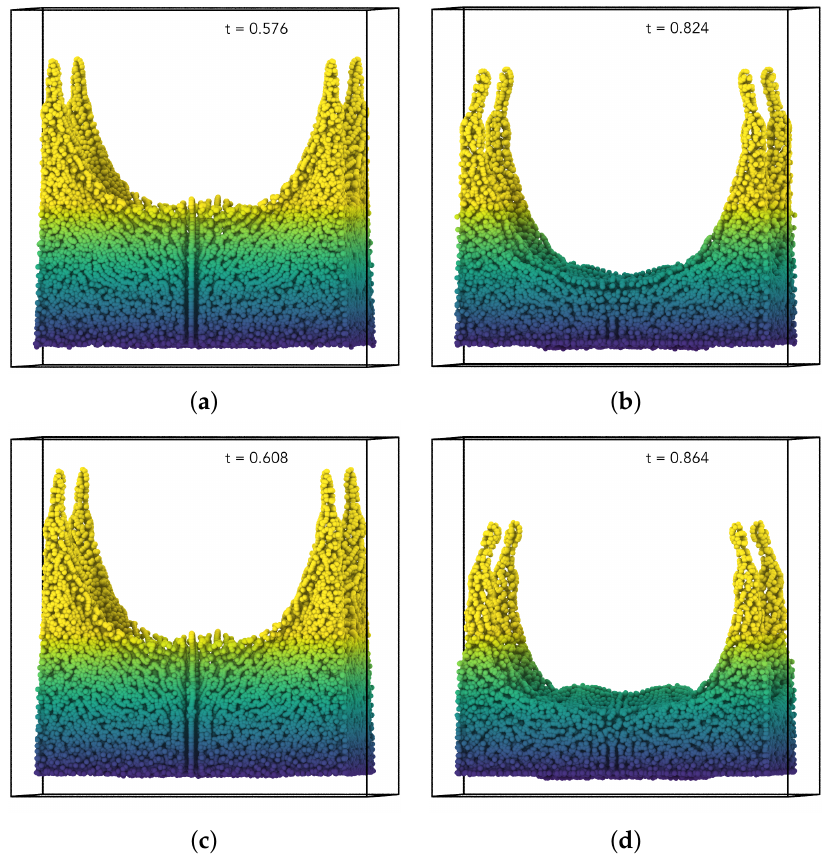
Figure 31. Column collapse at two different instants for different (cid:101) Soft / (cid:101) CS ratios. Experiments performed for π 2 = 9.9 × 10 2 . ( a ) (cid:101) Soft = 0.2 (cid:101) CS , t ≈ 0.4 τ ( τ = 1.50 s). ( b ) (cid:101) Soft = 0.2 (cid:101) CS , t ≈ 0.55 τ